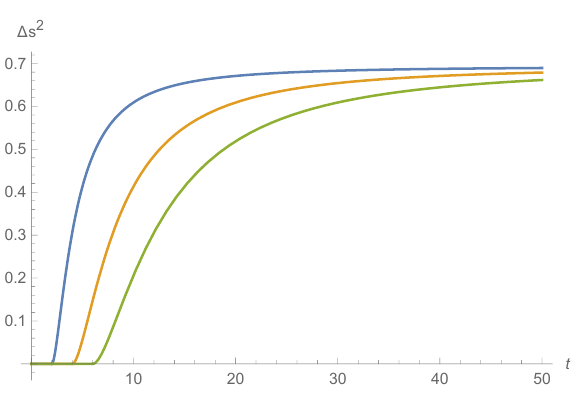
Figure 5. ∆ S (2) as a function for same components F rθ of the field strength. Blue line: x = 2 ; A orange line x = 4 ; green line x = 6 . We keep (cid:15) = 0 . 01 in all